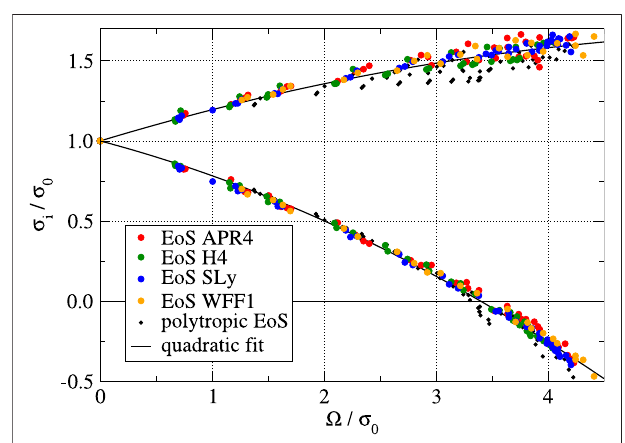
FIGURE 1 | Universal relations for the l (cid:1) | m | (cid:1) 2 f -mode frequencies for sequencesofconstantcentralenergydensityasobservedintheinertialframe. The graph shows the results from 21 such sequences (three sequences per EoS; three polytropic and four realistic EoSs). The potentially unstable f - mode branch displays a strikingly universal behavior; the largest deviations from a quadratic fi t occur close to the mass-shedding limit of the sequences, mainly for the polytropic EoSs. Figure taken from Krüger and Kokkotas (2020a) with permission by